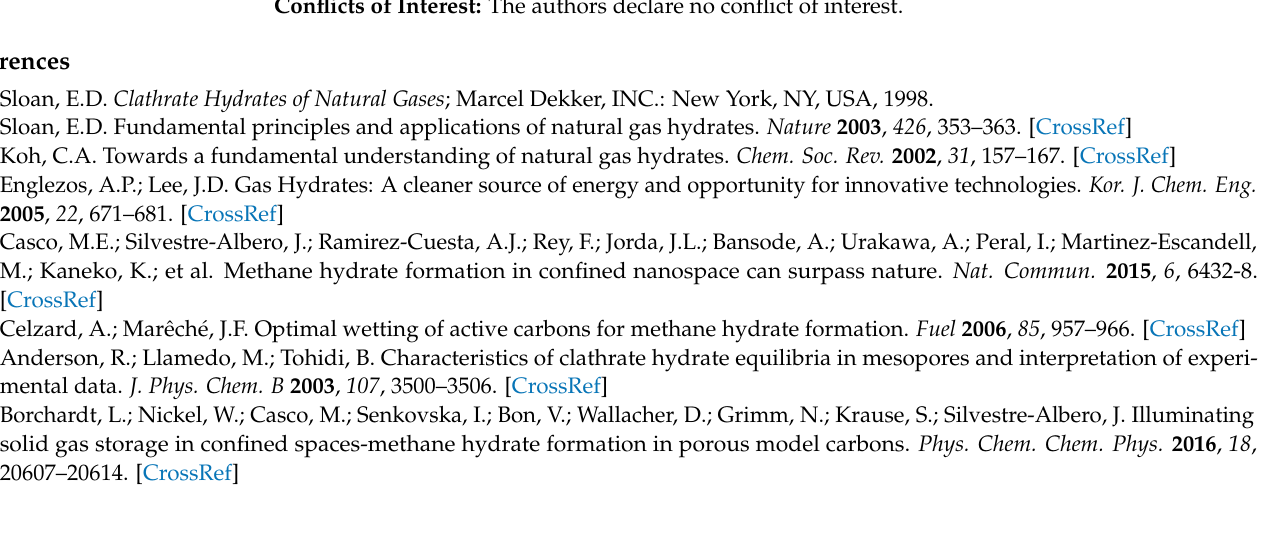
SG nanoparticles. Figure S3. Experimental apparatus of hydrate formation. Figure S4. Temperature and pressure profiles of the pressure vessel during the formation of the confined hydrate samples. Figure S5. Temperature evolution of relative integrated intensities from all fitting peaks. Figure S6. The IR spectra of pore water and water resulting from confined hydrate decomposition at 289 K. Table S1. The calculated lattice parameters of confined hydrate and bulk hydrate. References [66–77] are cited in the supplementary